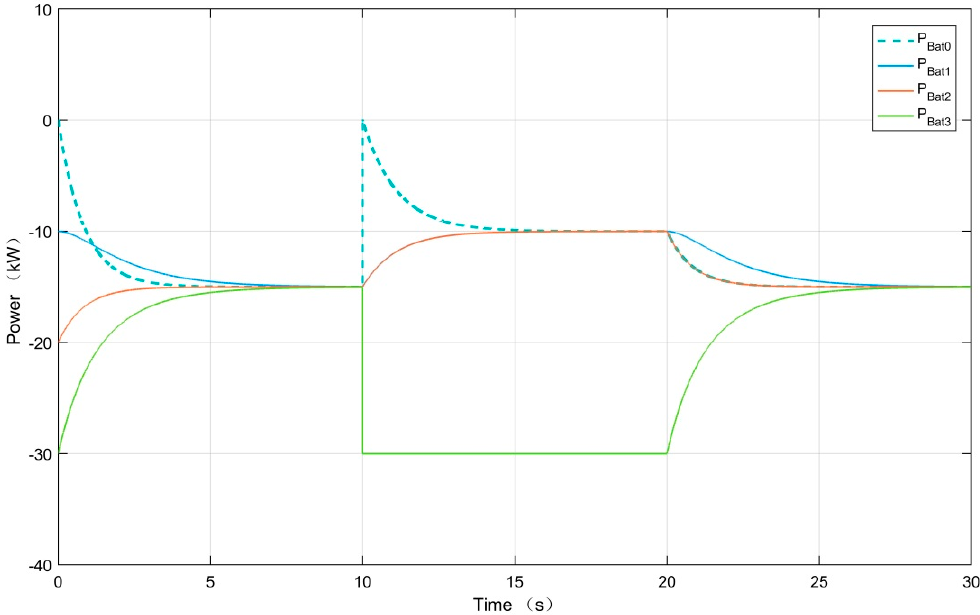
Figure 21. Battery power in modules.